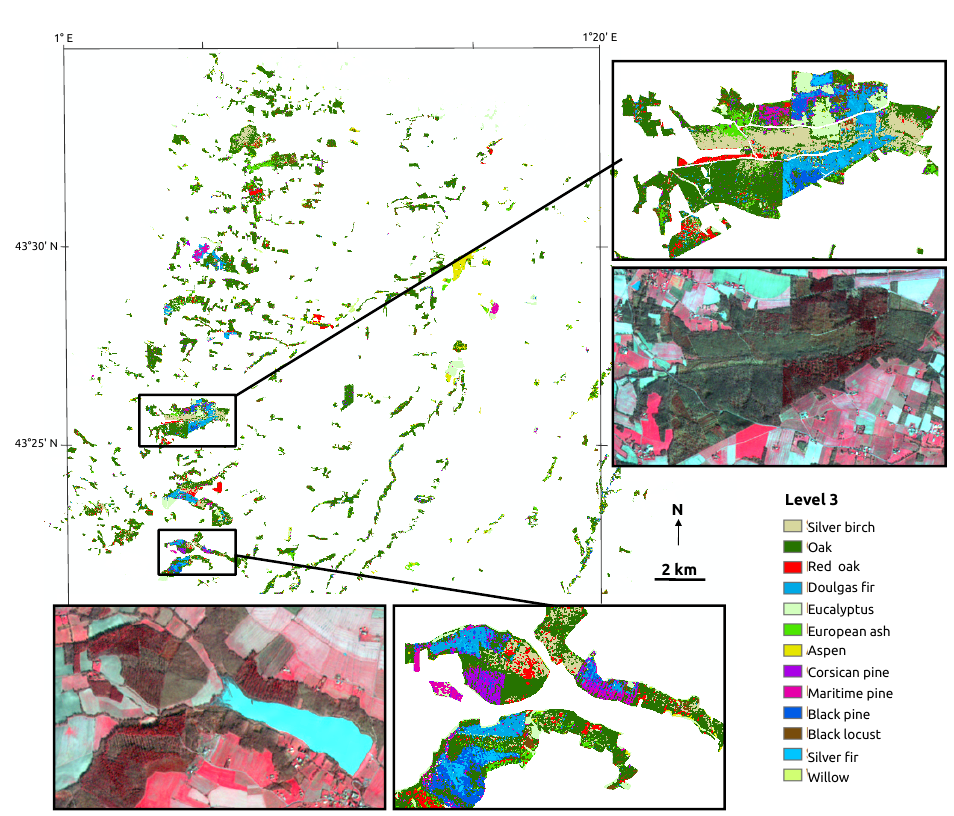
Figure 6. Map of forest tree species at level 3 based on the smoothed W bands dataset and the SVM classifier. Excerpts of image in false color infrared are derived from the winter Formosat-2 image acquired in 16 Februrary 2013. At this time, a clear distinction between conifer and deciduous tree species is